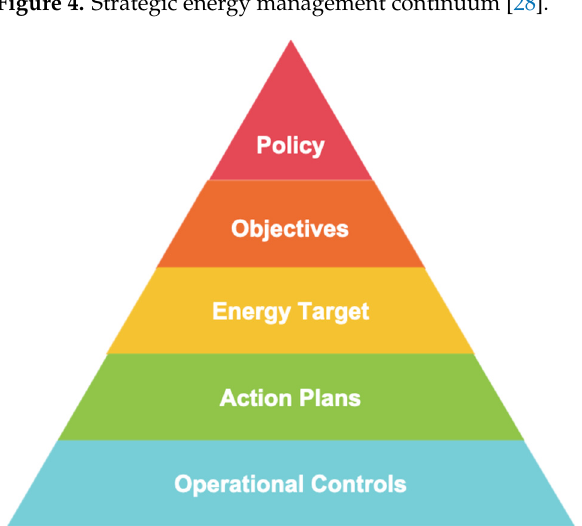
Figure 5. Energy success pyramid (source: author’s development).